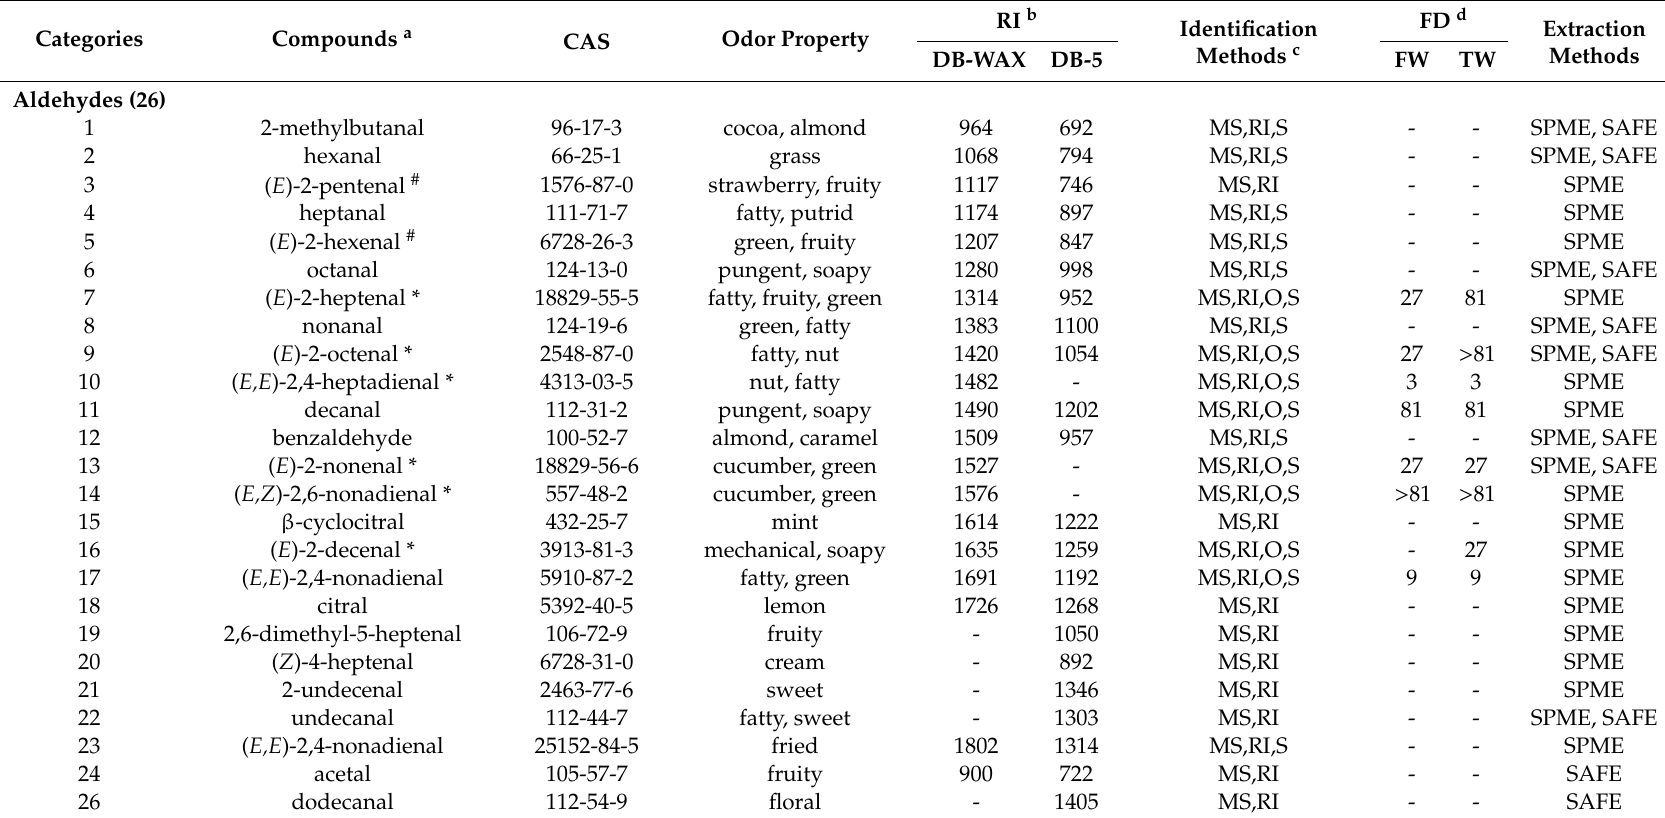
Table 2. Flavor compounds identified by gas chromatography–olfactometry–mass spectrometry (GC–O–MS) in fresh watermelon (FW) and thermally